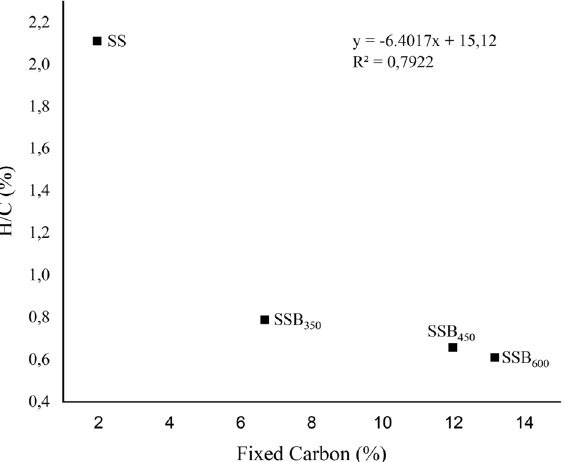
Figure 3. Correlation between ash and fixed carbon of sewage sludge (SS) and sewage sludge biochar (SSB) produced at the pyrolysis temperatures of 350 (SSB 350 ), 450 (SSB 450 ) and 600 (SSB 600 ).